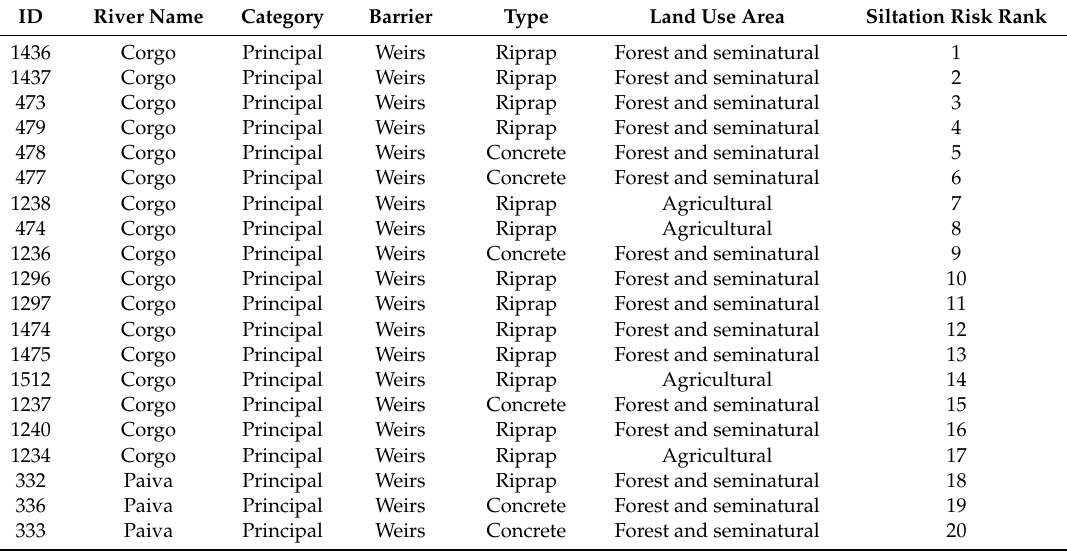
Table 1. Some characteristics of the 20 barriers with the highest siltation